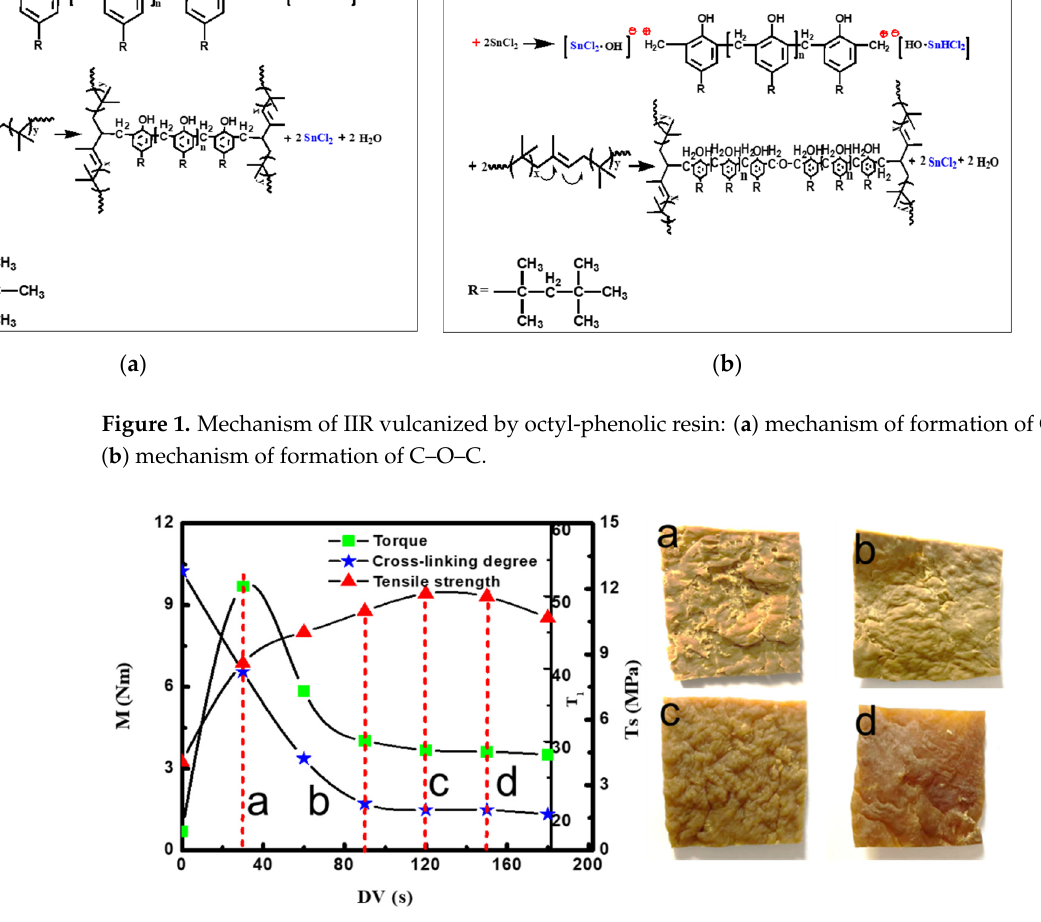
Figure 2. The evolution of torque (M), spin–lattice relaxation (T 1 ), and tensile strength (T s ) of IIR/PP- TPV with different DV times in torque rheometer. Samples with different DV times: (a) 30 s, (b)90 s, (c) 120s, and (d) 150 s. ( c ) 120 s, and ( d ) 150